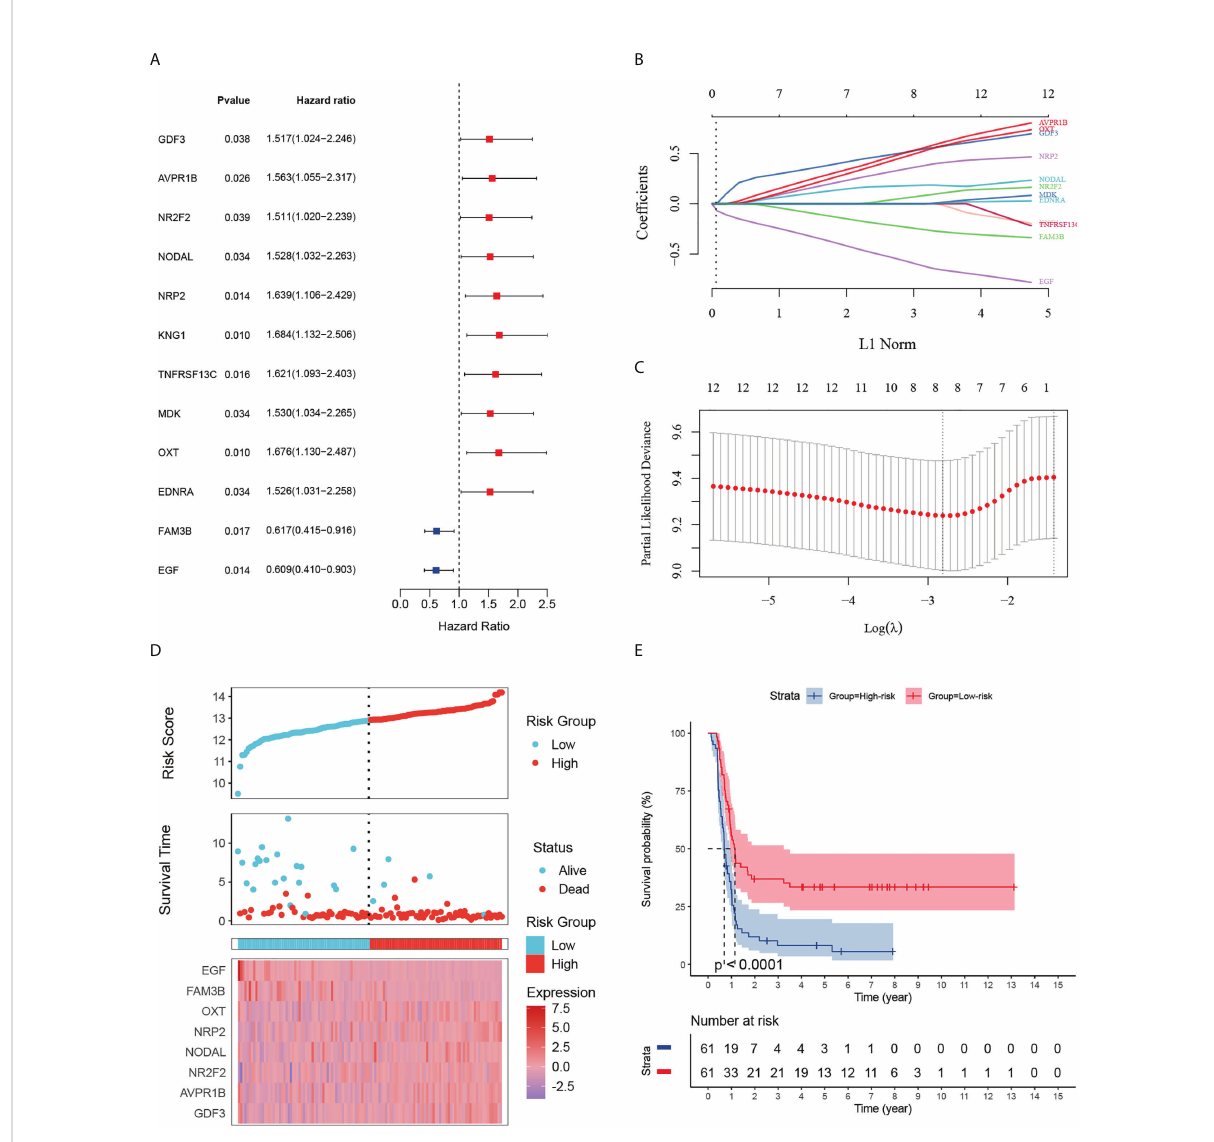
FIGURE 3 Identi fi cation of 12 survival-related IRGs and construction of an immune-related gene signature. (A) The forest map shows 12 genes signi fi cantly correlated with progression-free survival in the univariable COX regression analyses. (B) The trajectory of each independent variable. The log value of the independent lambda is represented on the horizontal axis, while the coef fi cient of the independent variable is represented on the vertical axis. (C) Partial likelihood deviance of variables revealed by the Lasso regression model. The two vertical dotted lines on the left and right, respectively, re fl ected optimum value according to the minimum and 1-SE criterion. The red dots re fl ected partial likelihood of deviance values, the gray lines represented standard error (SE). (D) Distribution of the riskscore, the associated survival status and the gene expression heatmap of the gene signature in the TARGET dataset. The median riskscore was used as the cutoff value, and patients were split into high-risk (red) and low-risk (blue) groups. (E) Patients in the high-risk subgroup exhibited poorer progression-free survival compared to those in the low- risk